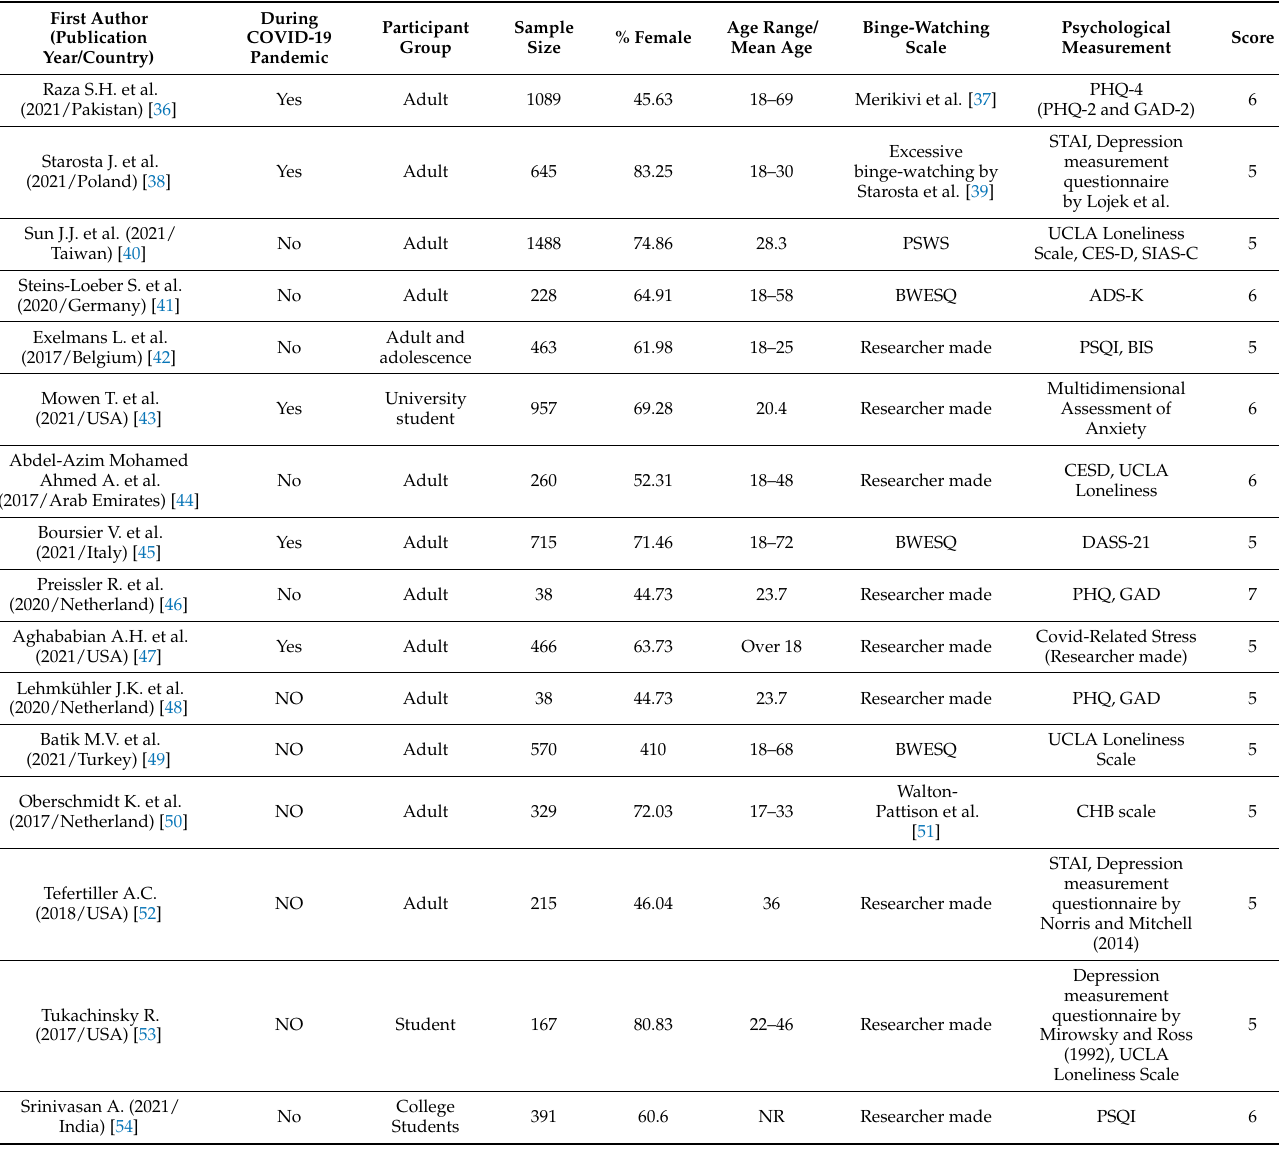
Table 1. The summarized characteristics of the included